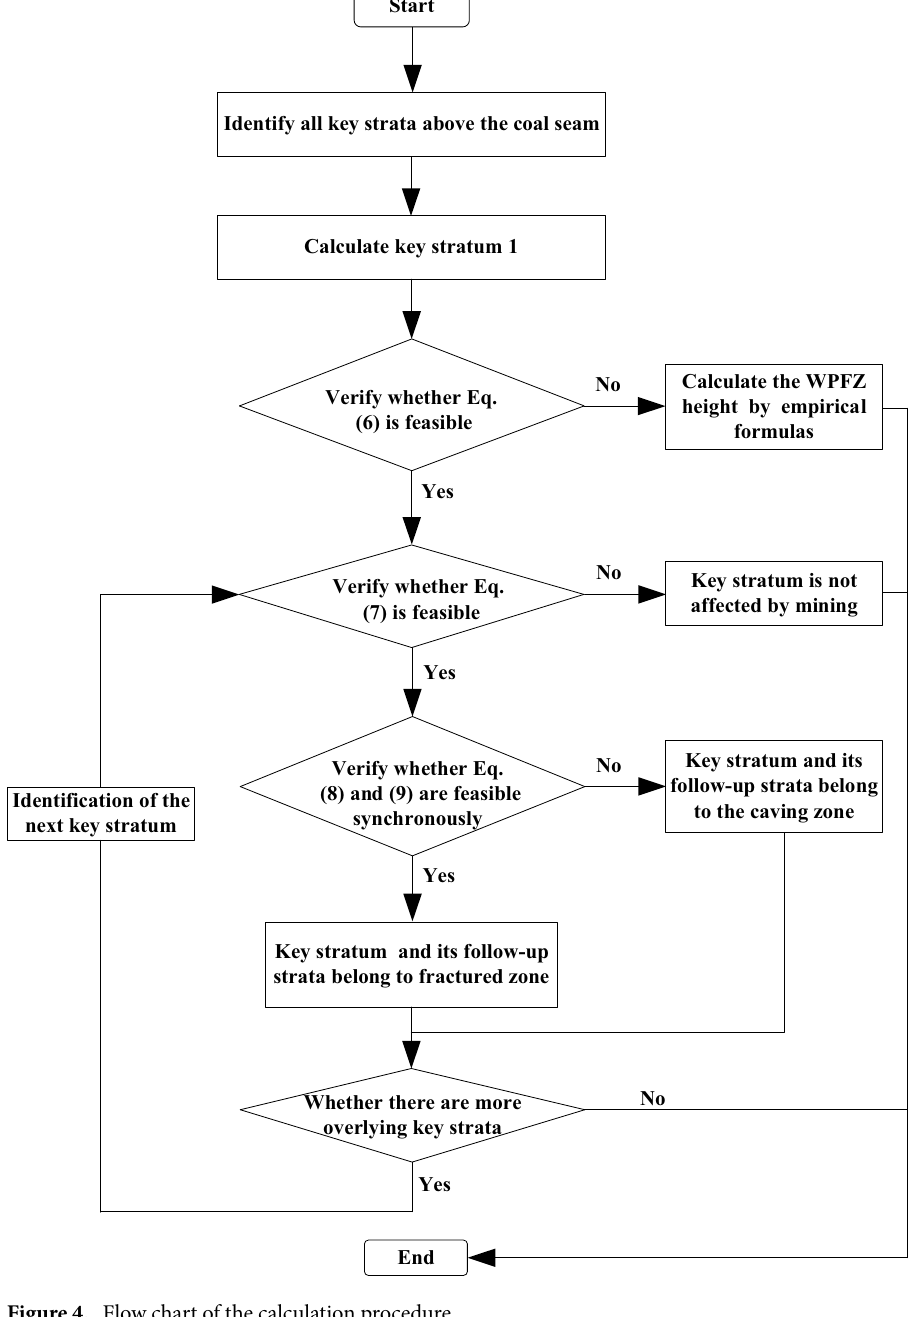
Figure 4. Flow chart of the calculation procedure.